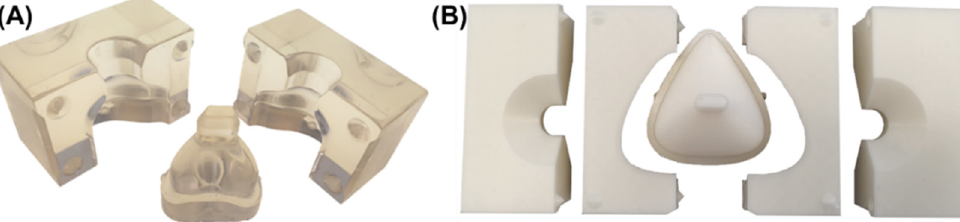
Figure 8. Manufactured molding form for nasal and oronasal mask. ( A ) SLA molding form for nasal mask ( B ) (from left to right) upper left part, lower left part, core, lower right, and upper right part of FFF molding form of oronasal mask.